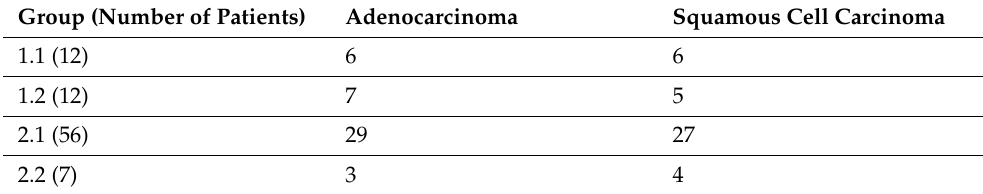
Table 3. Histology in the four groups. Group (Number of